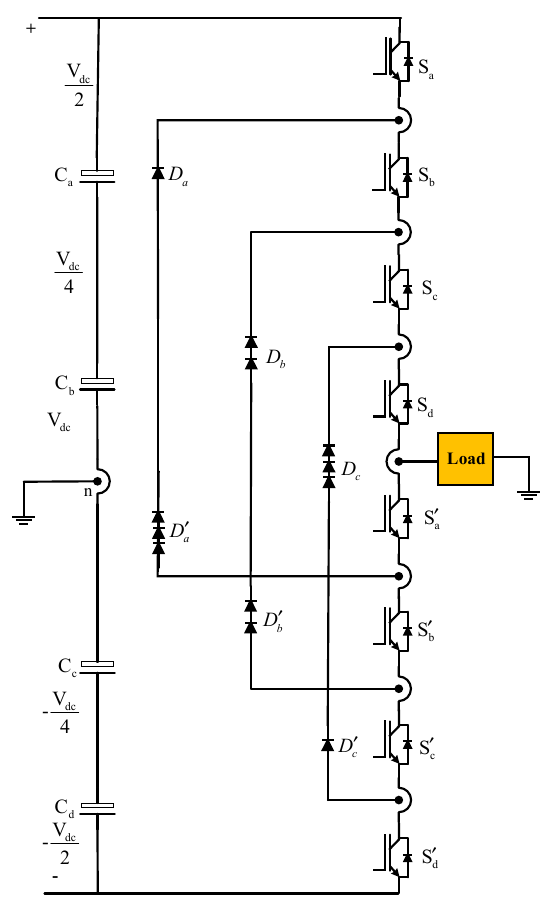
Figure 2. Five-level diode neutral-point clamped inverter.